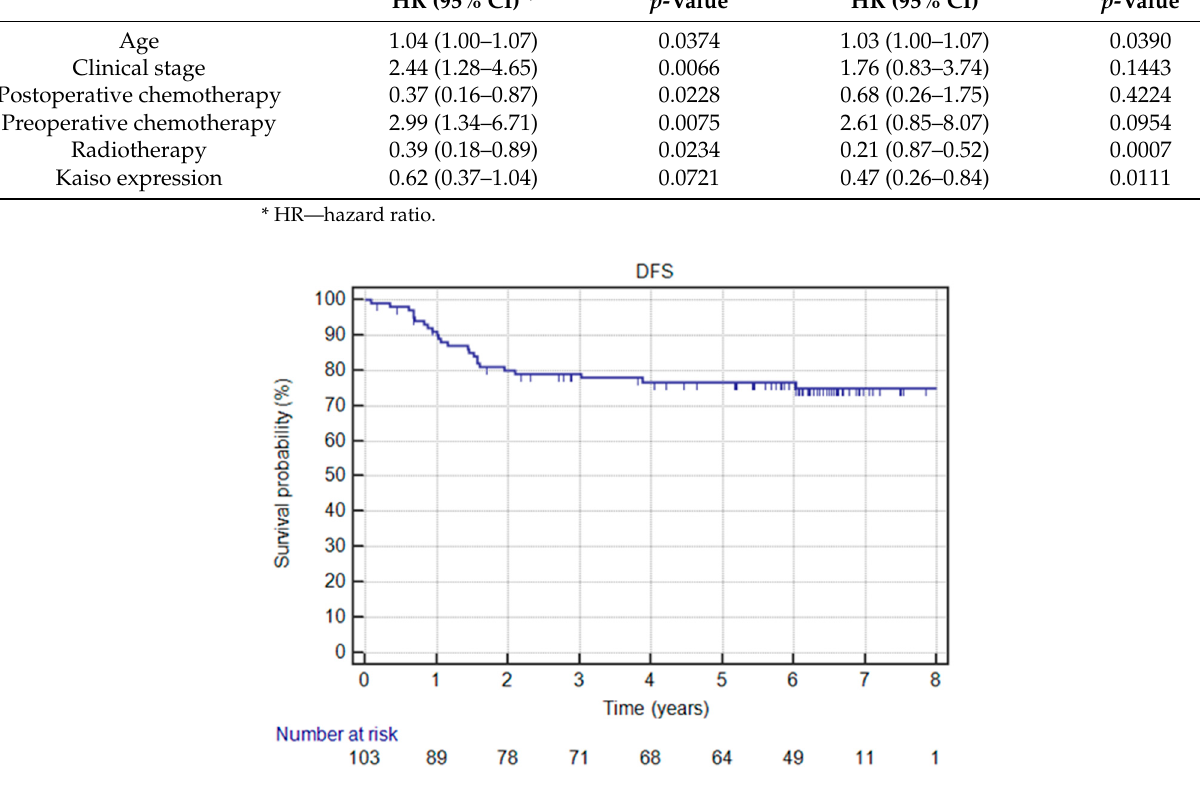
Figure 5. Disease-free survival (DFS) in the whole group. Table 5. Cox regression analysis for overall survival